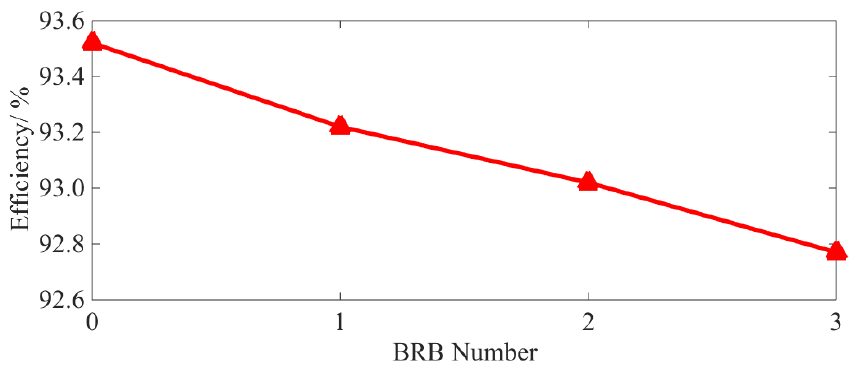
Figure 13. Characteristic curve of efficiency.